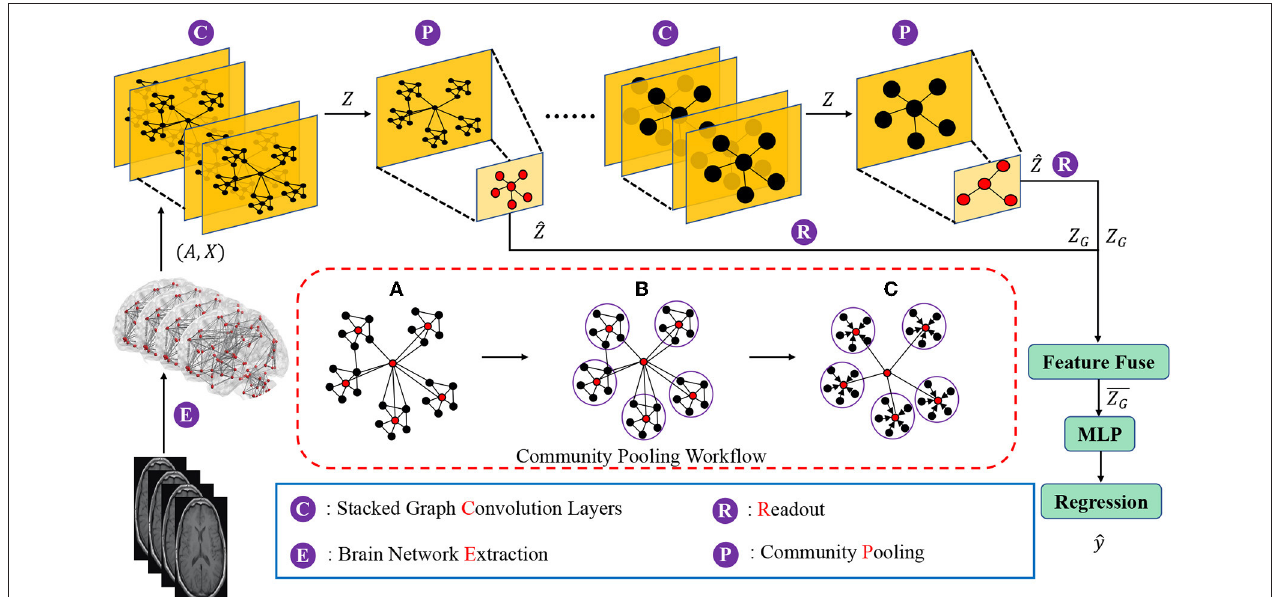
FIGURE 1 | Diagram of the proposed hierarchical brain network learning framework, including stacked graph convolution layers, community pooling modules, and an Multilayer perceptron (MLP) block for the regression task. The workflow details of the proposed community pooling module are presented in the red box, including: (A) Compute the center node probability ( P ) and select the nodes with top-M P scores as center nodes. (B) Assign each node into the closest community. (C) Aggregate features of community member nodes to the corresponding center node and down scale the graph based on the captured